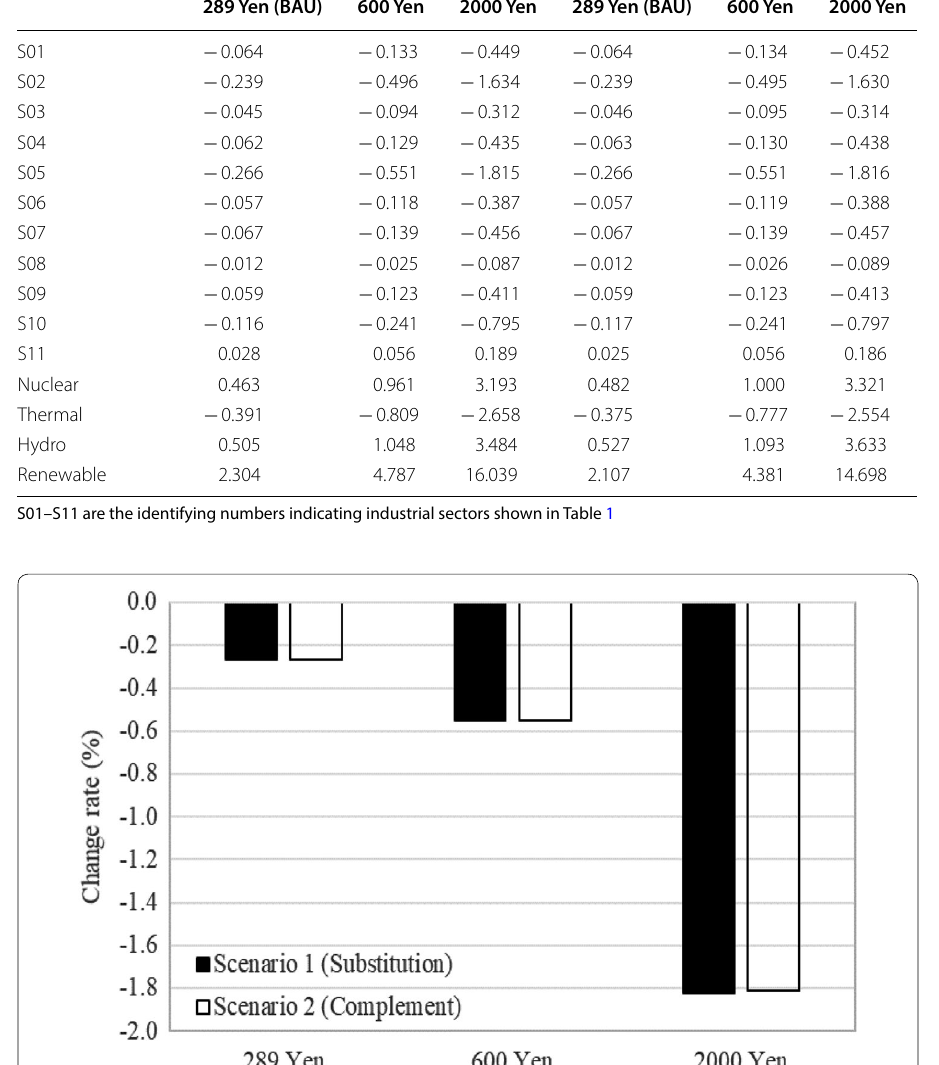
Table 7 Change rate (%) of GDP of each sector (S01–S11, N , T , H , R ) Industrial Sectors